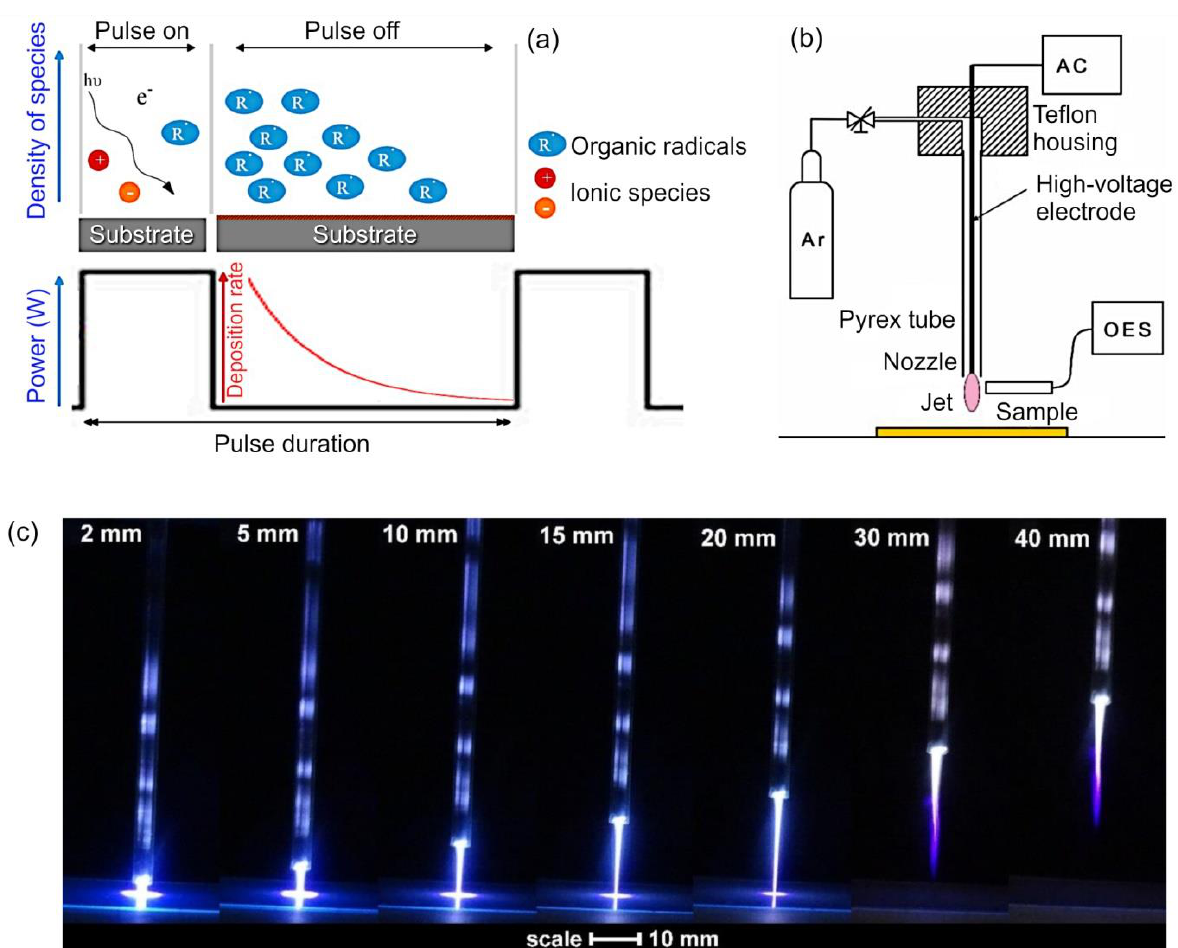
Figure 8. ( a ) Schematic representation of polymer deposition during pulse-on and pulse-off pulsed mode in plasma polymerization. Reproduced from Iqbal et al. (2018) [84] under conditions of the CC BY license. ( b ) Schematic drawing of the atmospheric pressure plasma jet system used for polymer surface modification, and ( c ) optical photograph of the plasma jet at various distances of the nozzle from the sample. Reproduced from Vesel et al. (2020) [87] under conditions of the CC BY license.